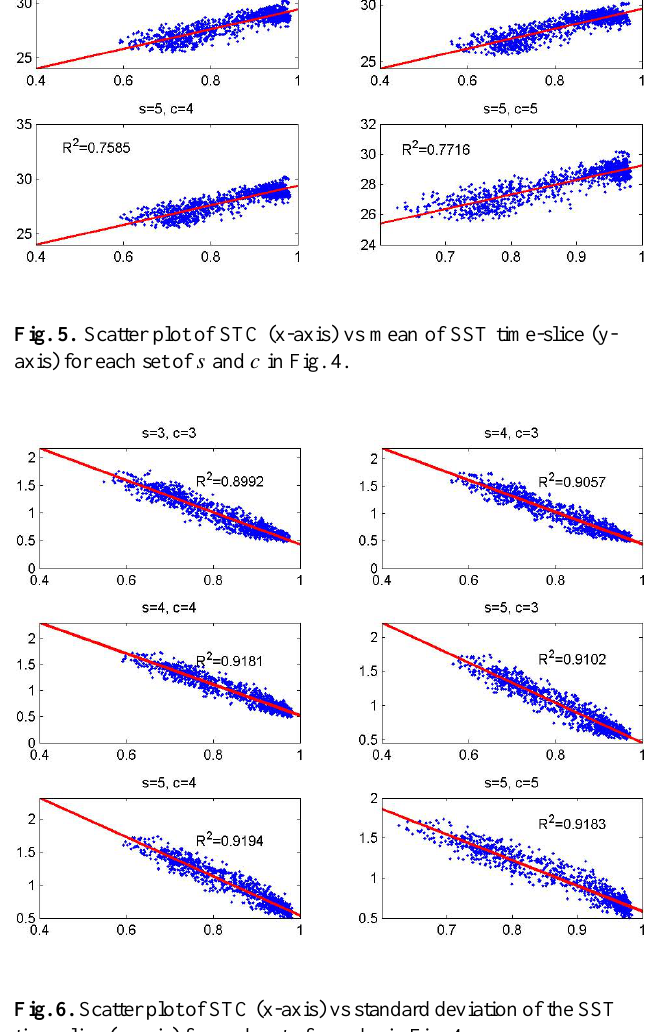
Fig. 6. Scatter plot of STC (x-axis) vs standard deviation of the SST time-slice (y-axis) for each set of s and c in Fig.